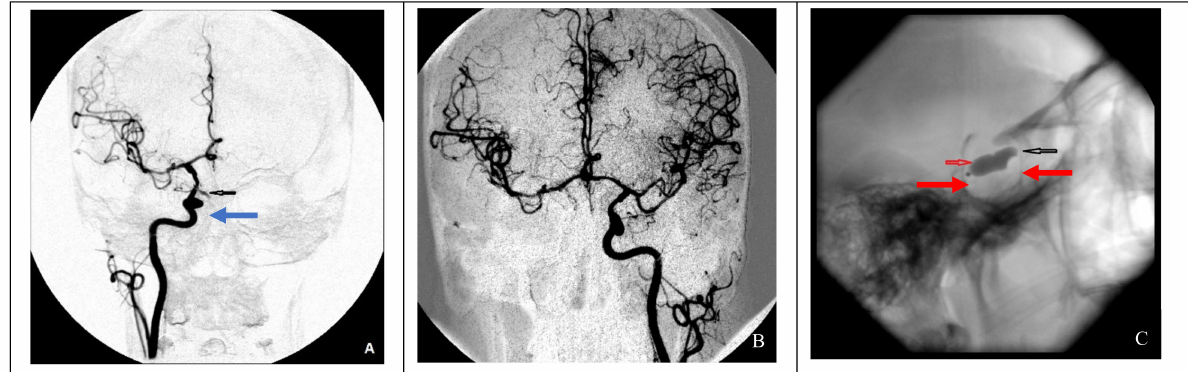
Figure 2. Endovascular surgical treatment in cases with good collateral circulation (clinical case 2). ( A ) A false aneurysm in the area of the cavernous segment of the right ICA (indicated by the blue arrow), ( B ) cerebral angiography of the left ICA demonstrating good collateral blood flow to the contralateral side, and ( C ) occlusion of a defect in the right ICA using two balloons (indicated by red arrows).